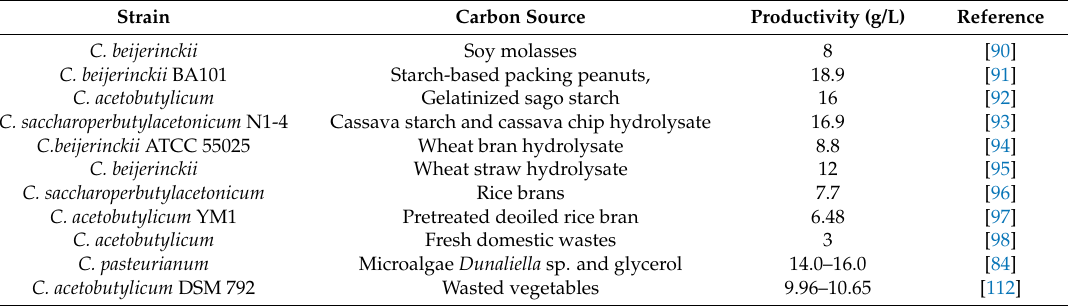
Table 2. Productivity of butanol by clostridia using different carbon